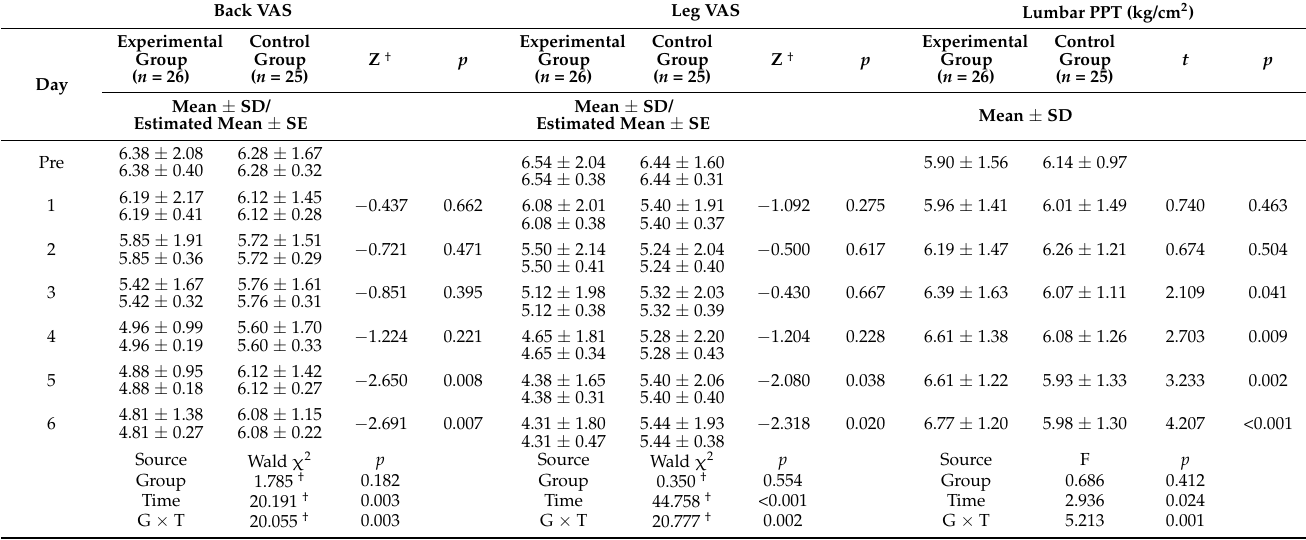
Table 3. Comparison of pain-related dependent variables between groups ( n =